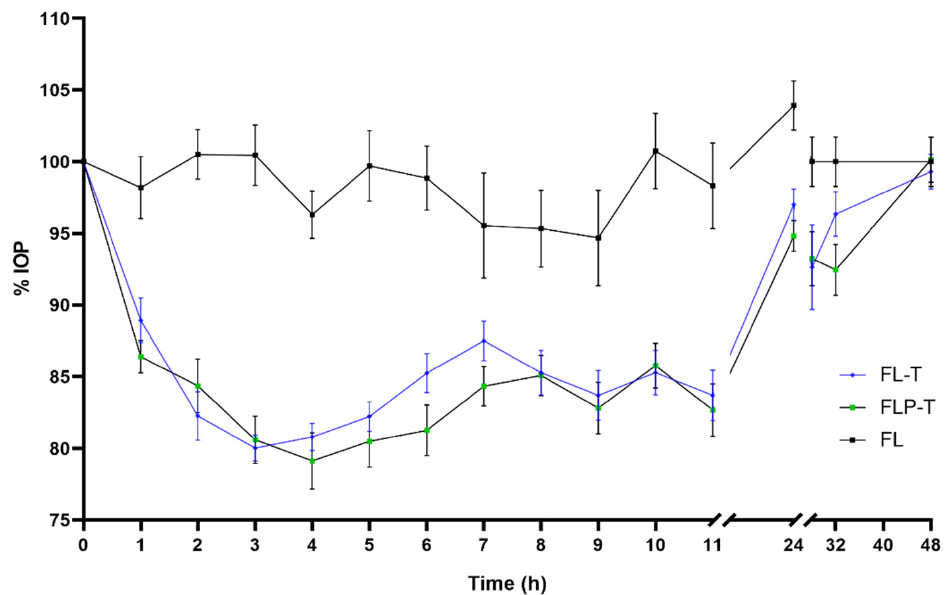
Figure 11. Decrease in intraocular pressure after administration of the liposomal formulation con- taining travoprost and HPMC (0–48 h), with statistical significance between FL-T and FLP-T formu-